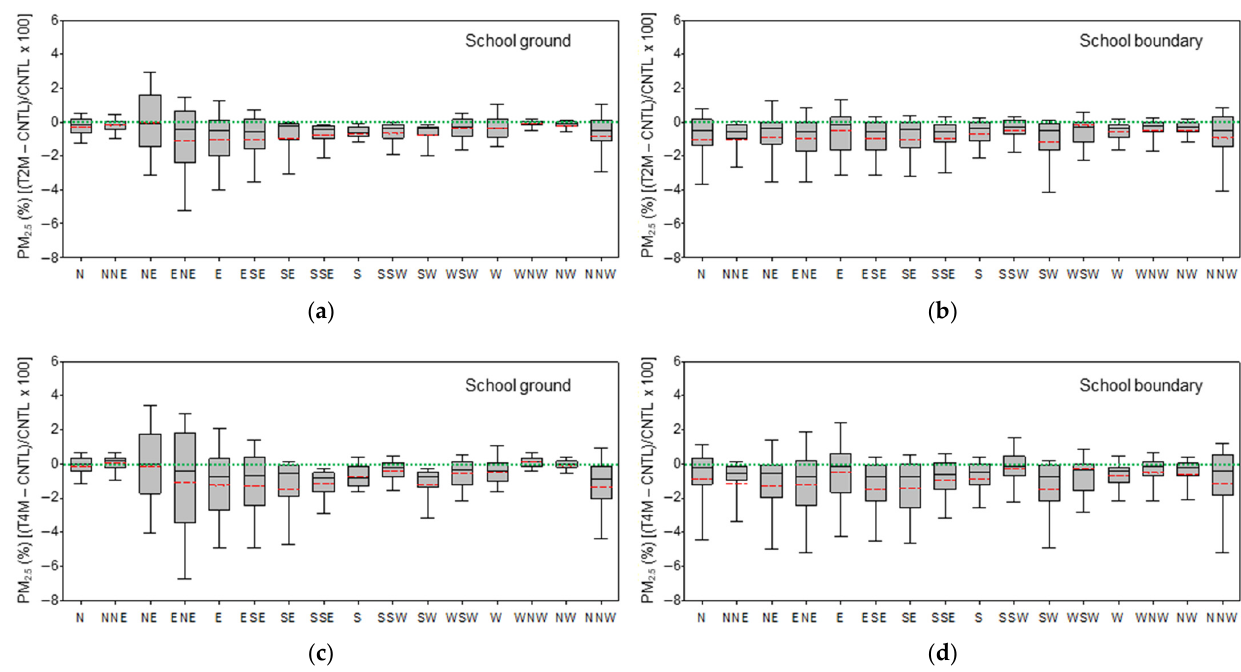
Figure 9. The same as Figure 5, but for T2M ( a , c ) and T4M ( b , d ) in the school ground (left panels) and school boundary (right panels).